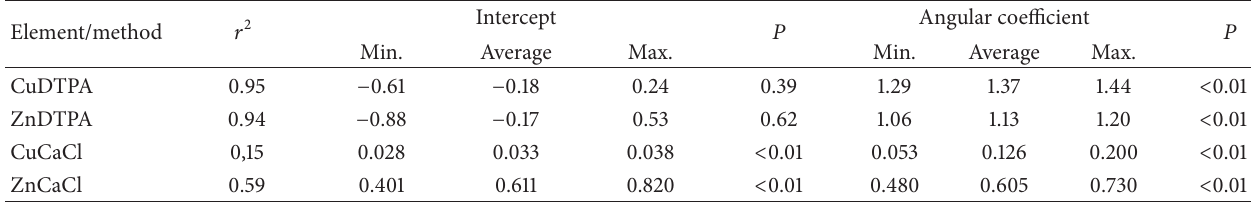
Table 2: Regression coefficients for the available forms of Cu and Zn extracted by DTPA and CaCl acidified (dependent variable) samples.